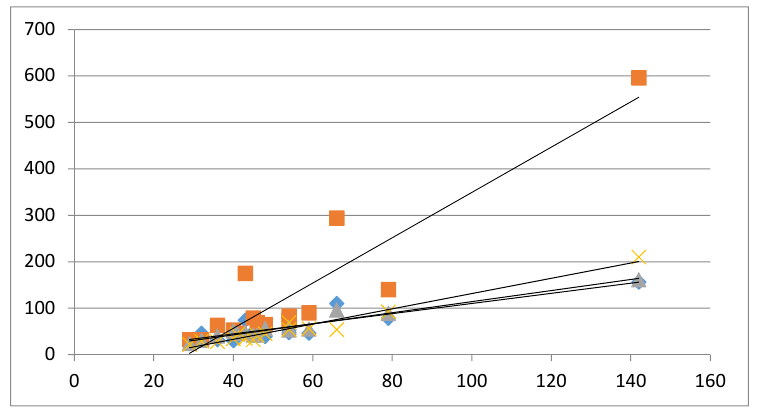
Figure 3. Environment evaluation based on mean population and across genotypes stability index data for seed yield (X-axis: mean population stability index values and Y-axis: cultivar stability index values in four environments).